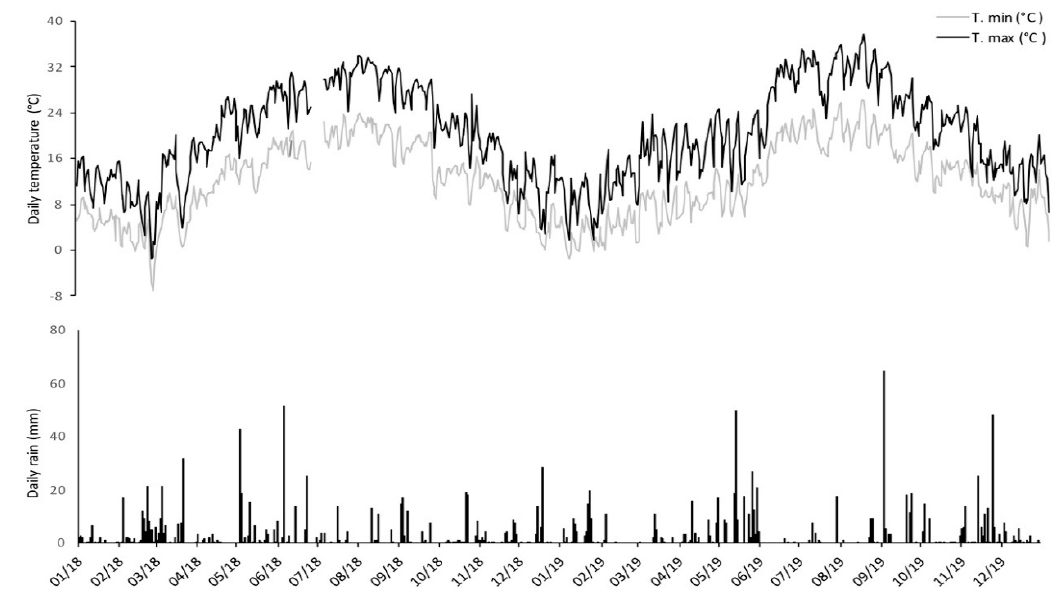
Figure 1. The daily rain (mm), and minimum and maximum temperature (°C) measured during the experiment (2018–2019) by a meteorological station located 3 km from the experimental field (Sistema Informativo Regionale Meteo ‐ Idro ‐ Pluviometrico).